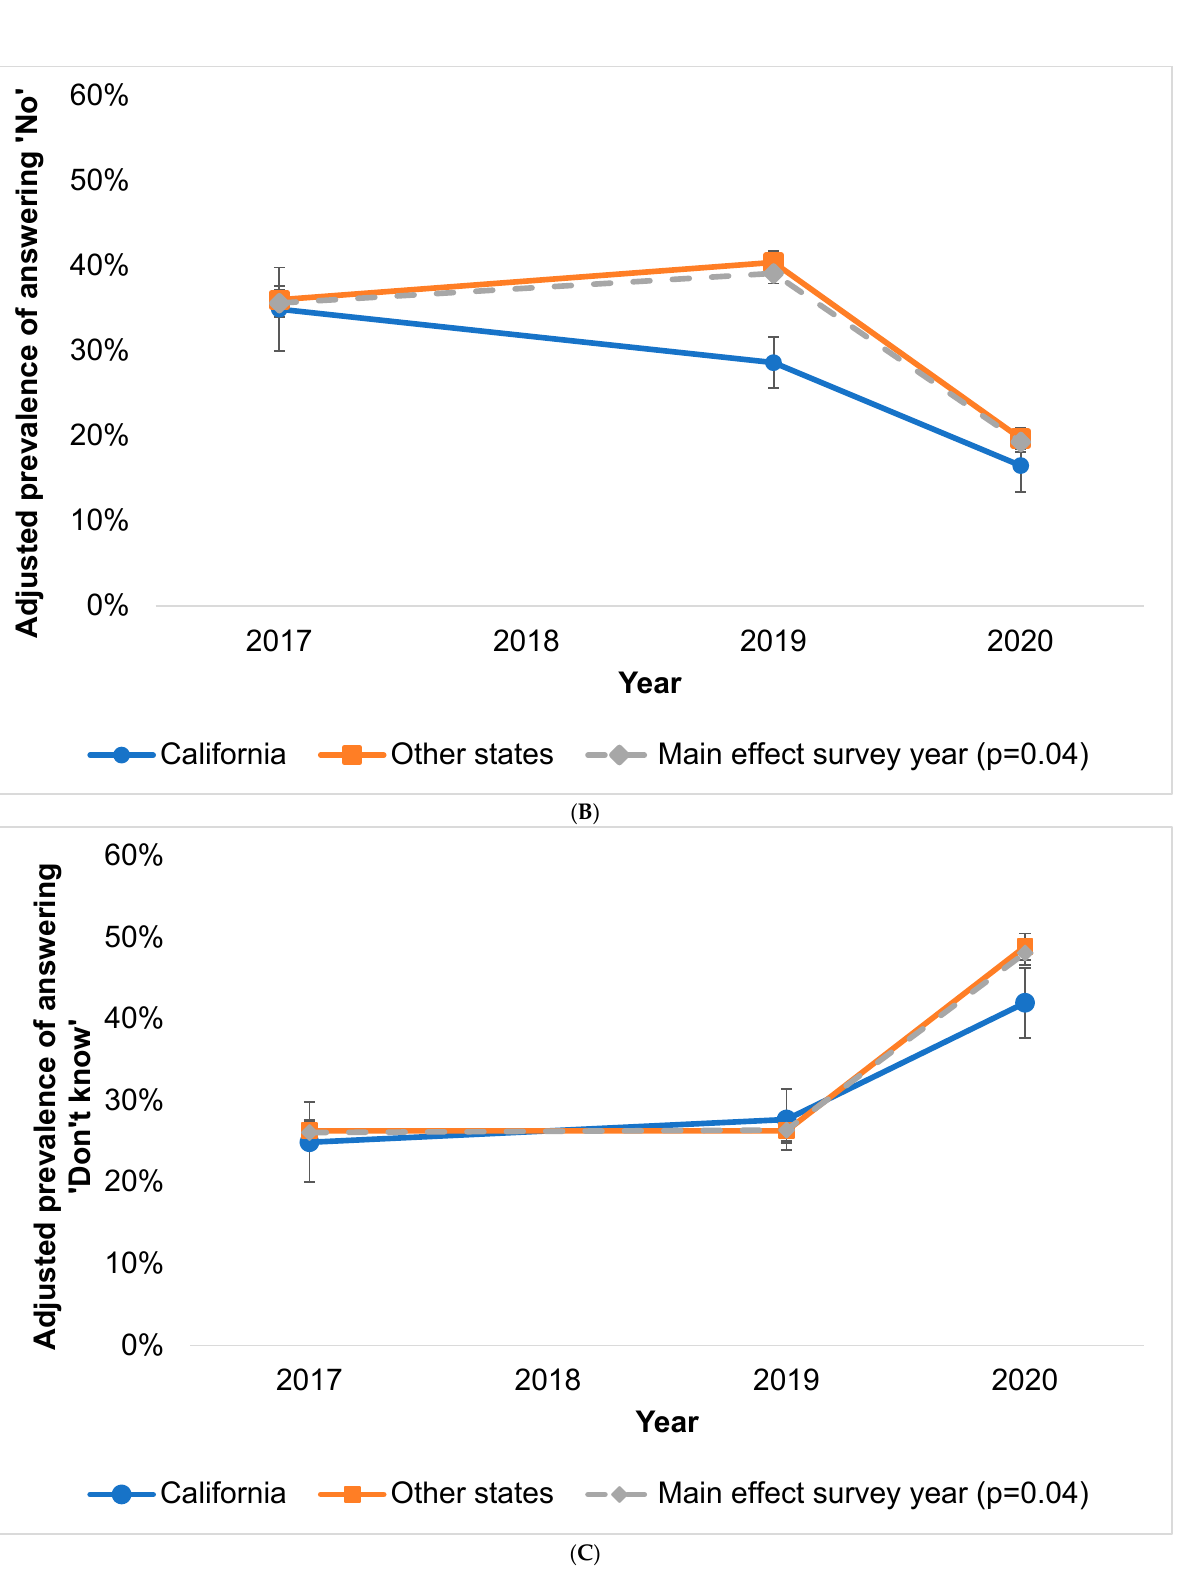
Figure 1. ( A – C ) Predicted marginals (adjusted prevalence) of alcohol and cancer knowledge re- sponses in survey year*location interaction model ( p = 0.32) with survey year main effect shown for comparison. ( A ) Adjusted prevalence of answering ‘Yes’ to alcohol and cancer knowledge item. ( B ) Adjusted prevalence of answering ‘No’ to alcohol and cancer knowledge item. ( C ) Adjusted preva- lence of answering ‘Don’t know’ to alcohol and cancer knowledge item (error bars represent 95% Cis).